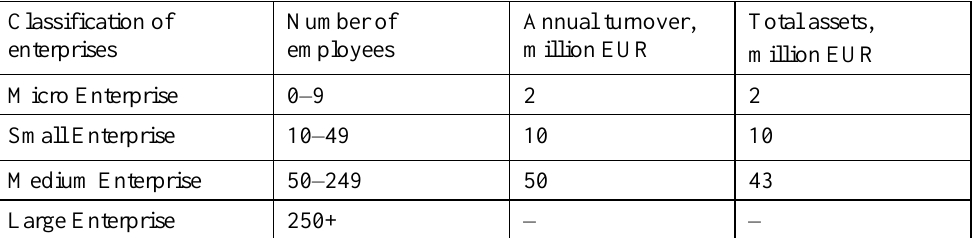
Table 5. Criteria for classification of enterprises in